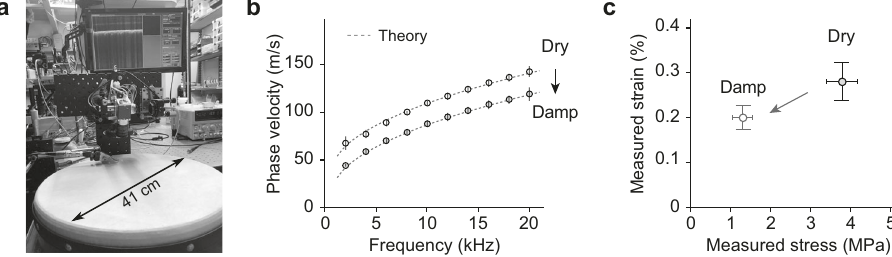
Fig. 3 Measuring the stress in a drum head. a Photograph of the experimental set up. A real-time Optical Coherence Tomography image is displayed in the monitor. b Dispersion relations measured in the dry (upper) and damp (lower) states. Markers, experiment. Dashed curves, theory. c Stresses and strains measured in the dry and damp states. Error bars are the standard deviations over fi ve measurements.